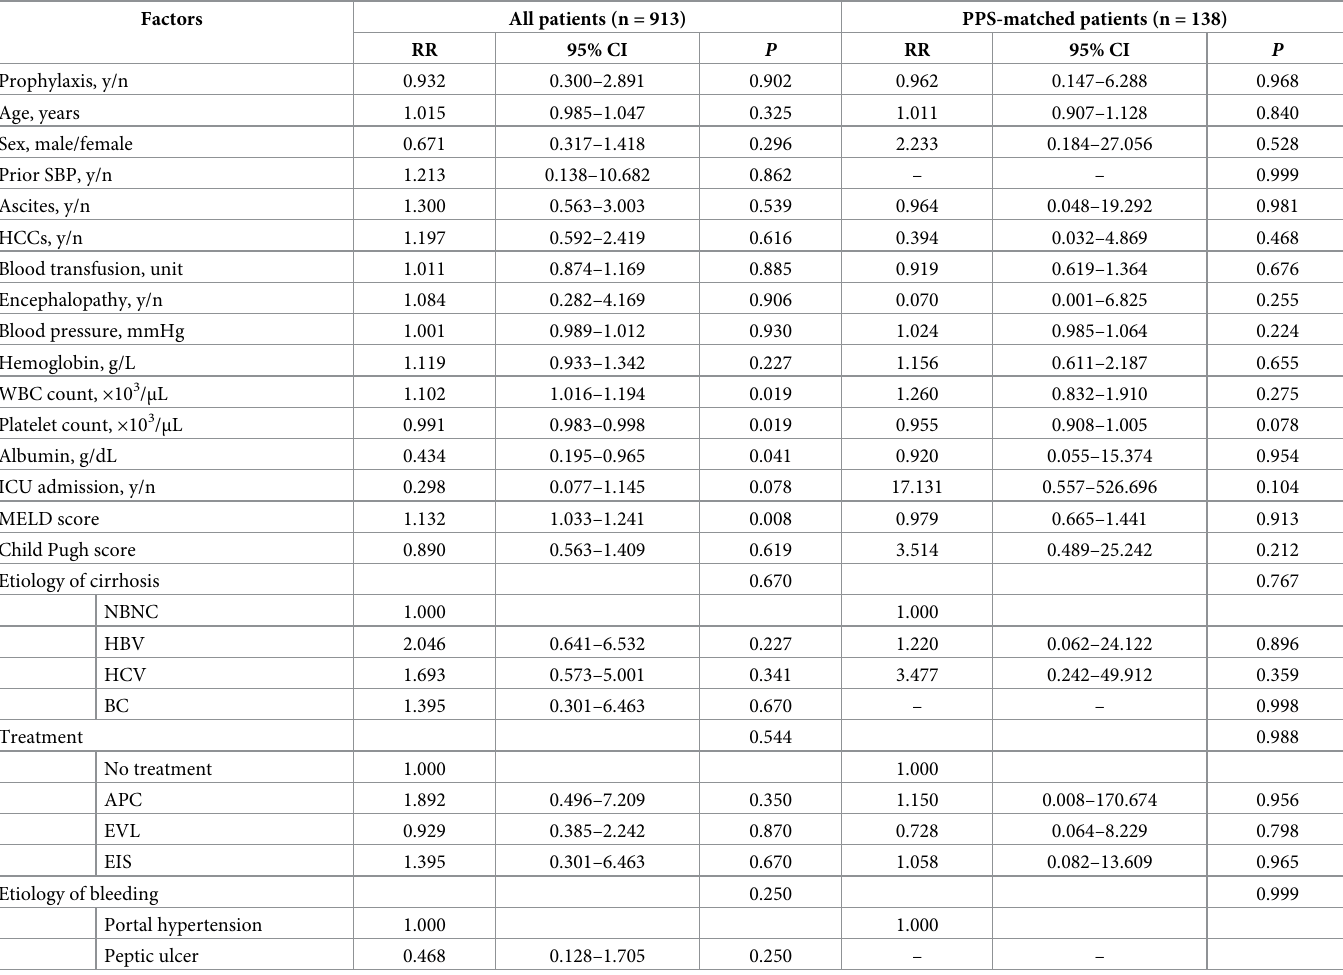
Table 3. Factors associated with bacterial infection risk within 14 days †